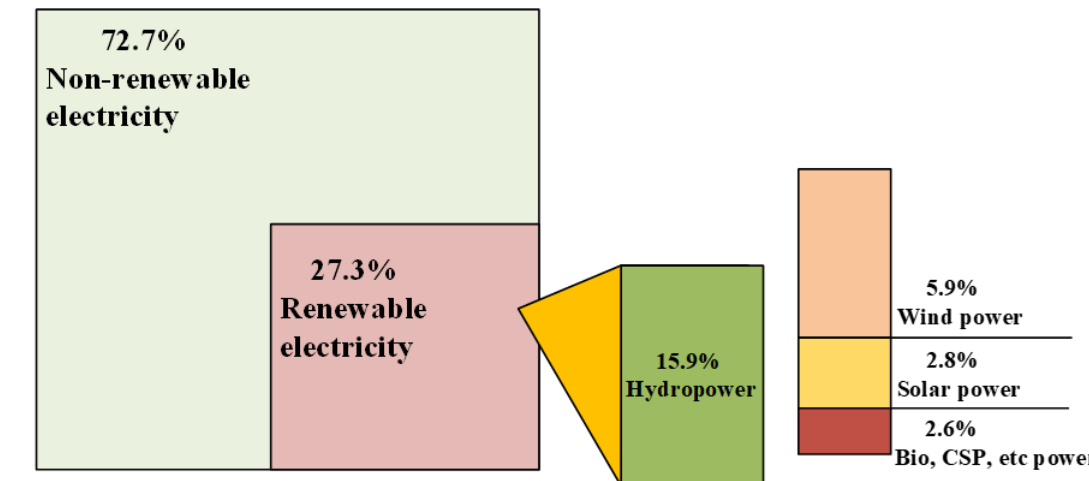
2 of 16 During mismatch, the affected (shaded) PV cells generate less current than the string current. Therefore, the bypass diodes are used in parallel to PV cells or a group of series- connected cells. These bypass diodes bypass the low-power-producing cell or subpanel [4,5]. Hence, the string current starts to flow through these conducted diodes, as depicted in Figure 2b. The bypassed PV cells are shorted out. Therefore, there is no contribution from these PV cells towards the string’s output. Additionally, these bypass diodes cause multiple MPPs under mismatch due to the bypassing of low power-producing PV cells, as visualized in Figure 2c. These nonconvex output power characteristics lead to further complications for the maximum power point tracking (MPPT) algorithms in tracking the